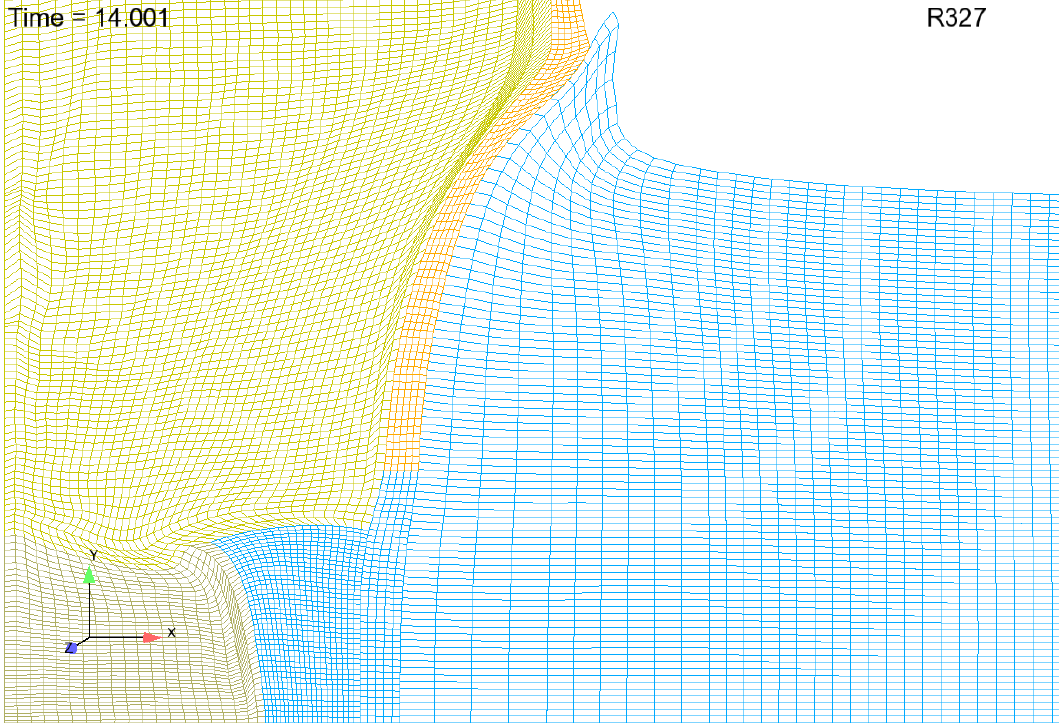
Figure 5. Jet morphology resultant from mesh employing a gradation